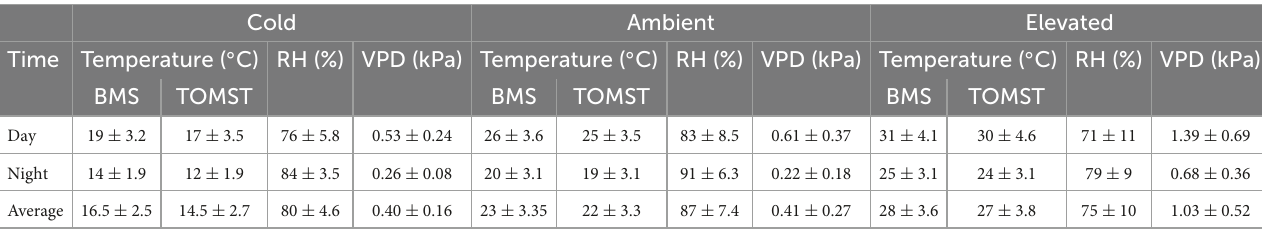
TABLE 1 Environmental conditions in the glasshouse during the experiment for the three glasshouse chambers. Cold Ambient